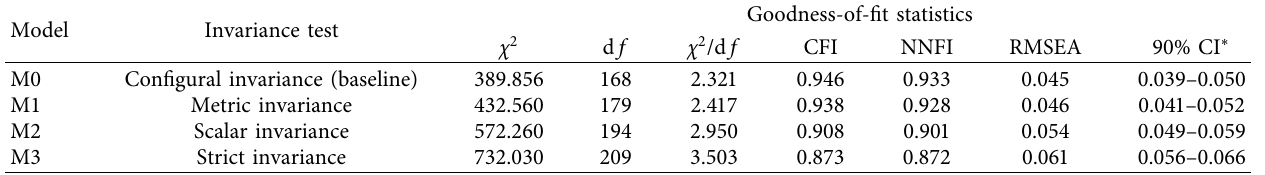
Table 12: Goodness-of-fit statistics for multisample structural equation models (LK versus HK). Model